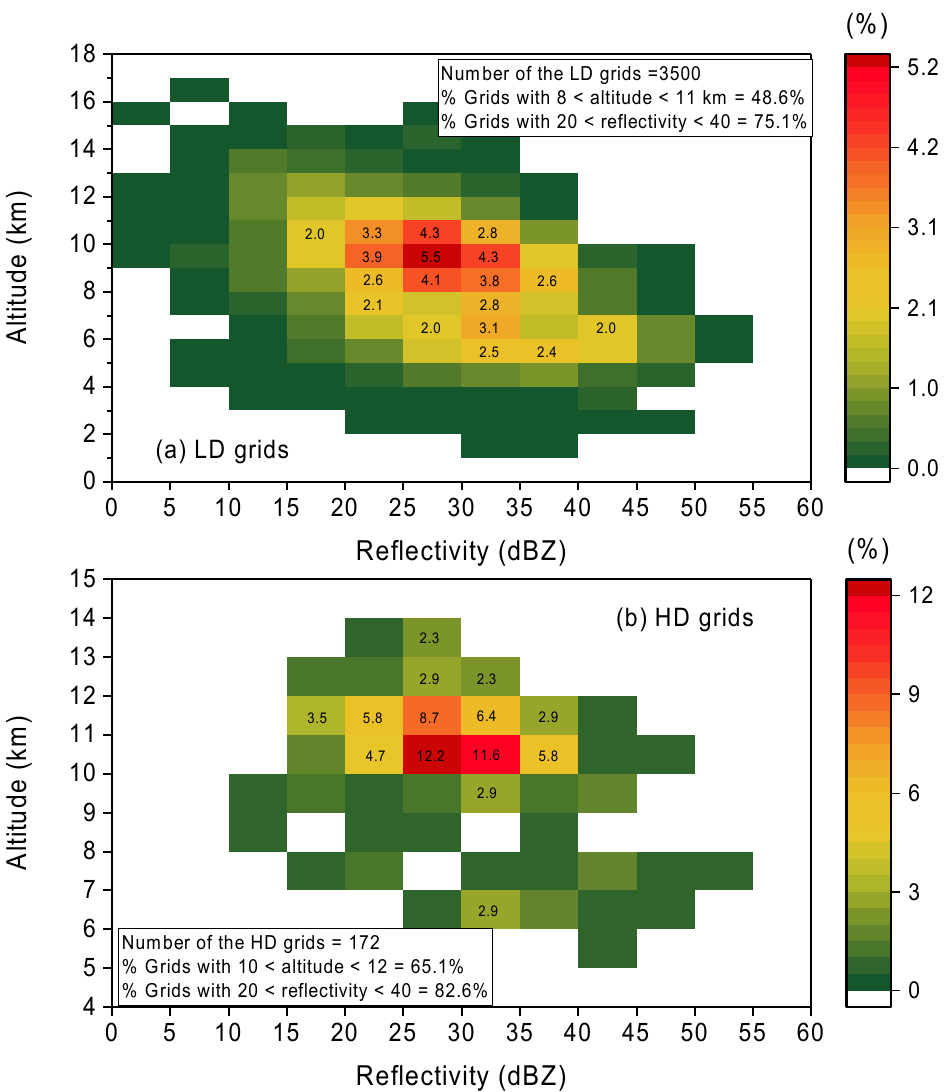
Figure 3. Two-dimensional histogram of the ( a ) LD and ( b ) HD grids relative to radar reflectivity and altitude for the 14 MCSs.